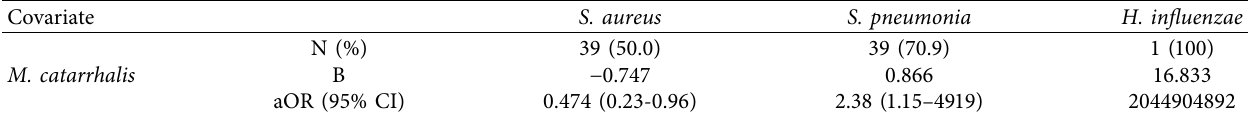
Table 4: Multiple logistic regression analysis of bacterial